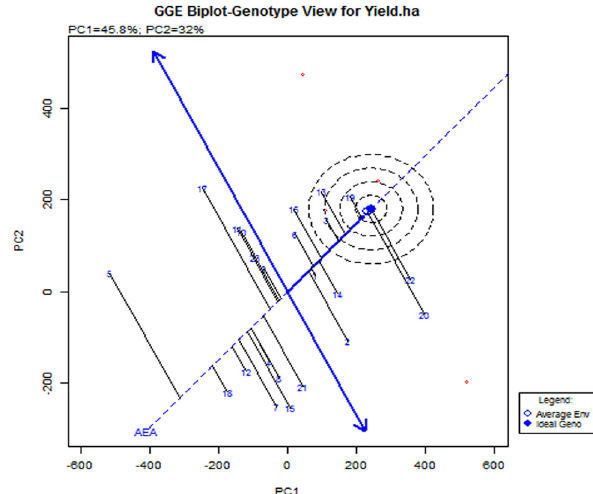
Figure 3: Discriminating and representativeness view of the GGE biplot and ranking of test environments relative to an ideal